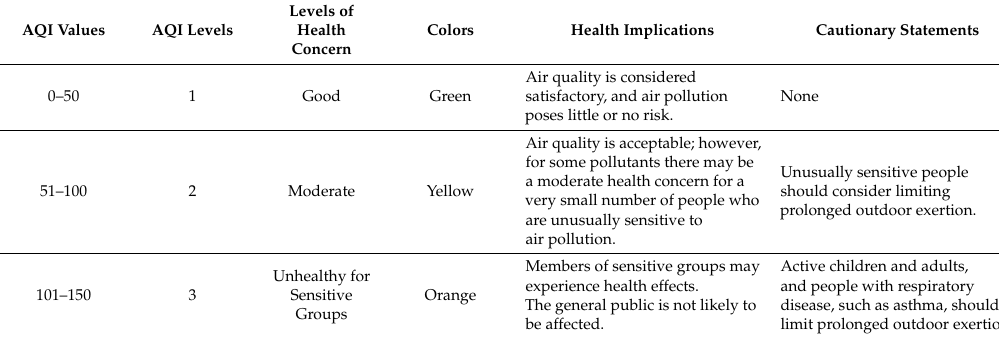
Table 3. Air Quality and Health